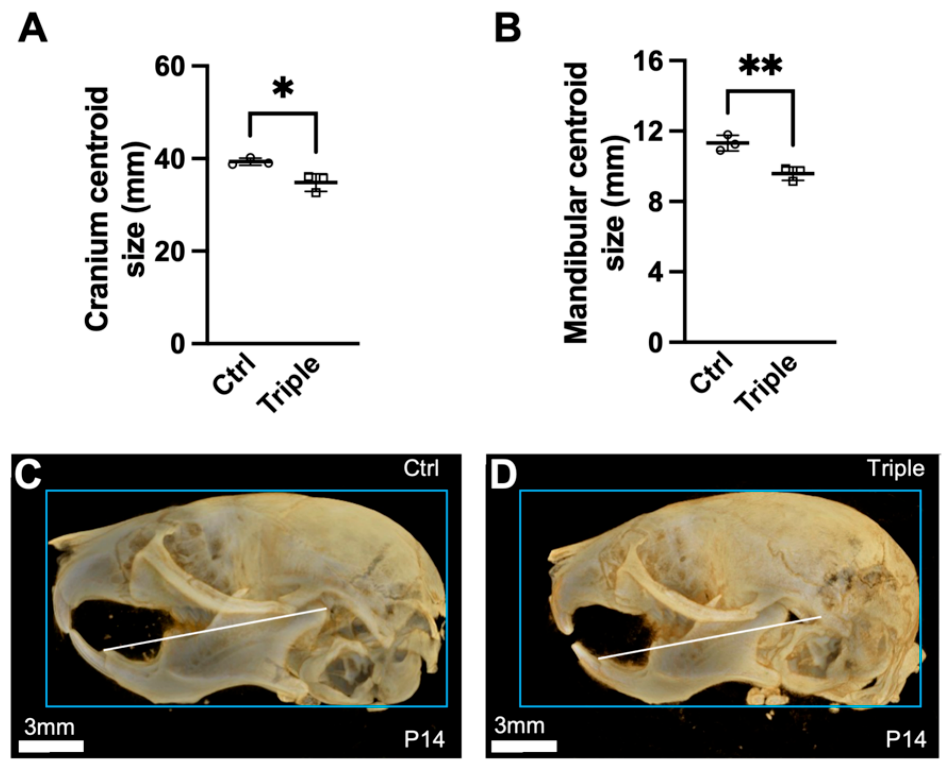
Figure 3. Centroid size differences in Thm2 − / − ; Thm1 aln/+ mice. ( A ) Cranium centroid size and ( B ) Mandibular centroid size. ( C ) MicroCT 3D reconstructions of of control and ( D ) Thm2 − / − ; Thm1 aln/+ mouse skulls. The blue box (same size) in both images shows the overall cranium size difference and the white line (same length) in both images shows the overall mandibular size difference. n = 3 control; n = 3 triple allele mutant. Data points represent individual mice. Bars represent mean ± SD. Statistical significance was determined using unpaired t -tests. * p < 0.05; ** p < 0.01.